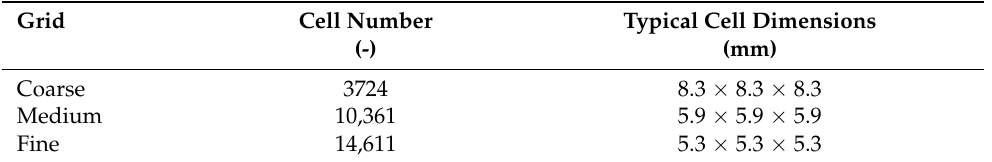
Table 10. Cell number and typical cell dimensions of the investigated grids for the simulation of biomass gasification using ilmenite as an oxygen carrier.